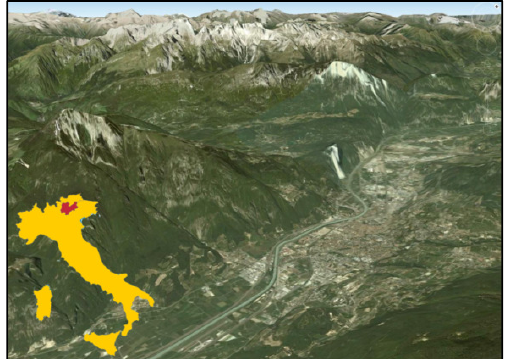
Figure 1: The city of Trento and the surrounding environs, in the North-East of Italy (image source: Google